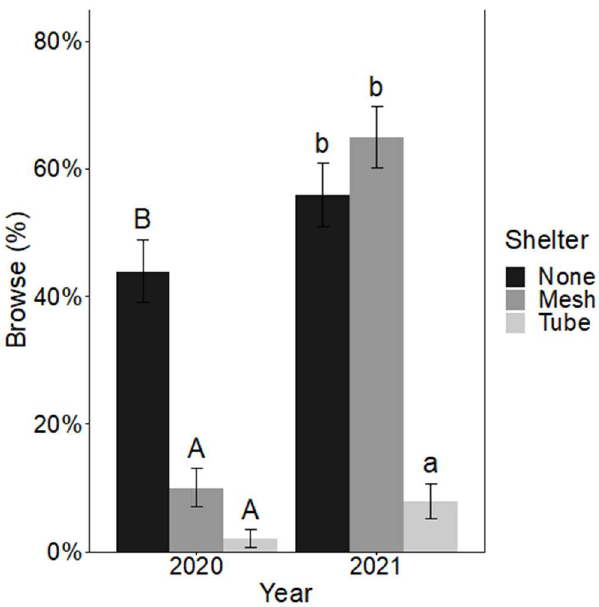
Figure 3. Mean ± SE percent browse incidence (%) on Quercus virginiana seedlings after the first growing season (2020) and the second growing season (2021). Seedlings either had no tree shelter, a mesh tree shelter, or solid-wall tube tree shelter. Different letters (uppercase letters for 2020 comparisons and lowercase letters for 2021 comparisons) indicate significant differences among the shelter treatment levels (α = 0.05).